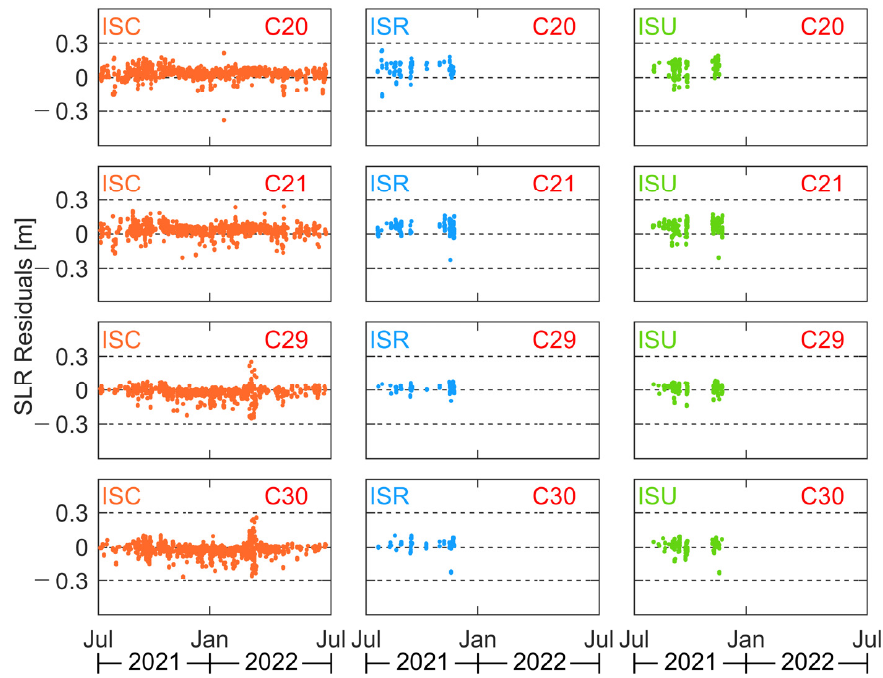
Figure 14. SLR residuals of BDS-3 satellites based on three types of iGMAS B1C/B2a orbits.